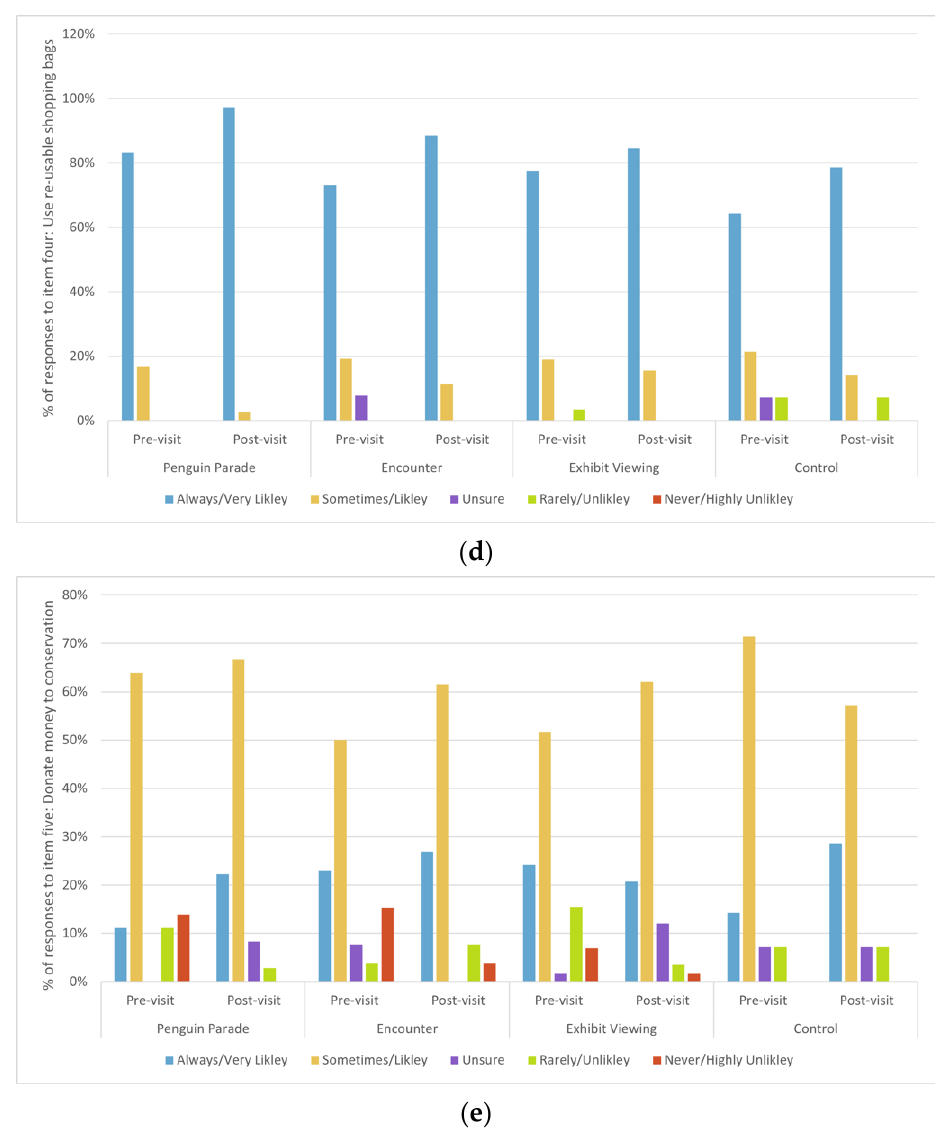
Figure 2. Percentage of responses belonging to each Likert category (where 1 = always and 5 = never in the pre-visit questionnaire, and 1 = very likely and 5 = highly unlikely) in the post-visit question- naire completed by zoo visitors classified as having had one of four types of visit (viewed a penguin parade, had a penguin encounter, viewed the penguin exhibit or none of these experiences (con- trol)).Answers were provided in response to how often they already/are likely to ( a ) buy sustainable fish, ( b ) volunteer for conservation, ( c ) tell friends how they can help to conserve wildlife, ( d ) use re-usable shopping bags and ( e ) donate money to conservation, pre- and post-visit.